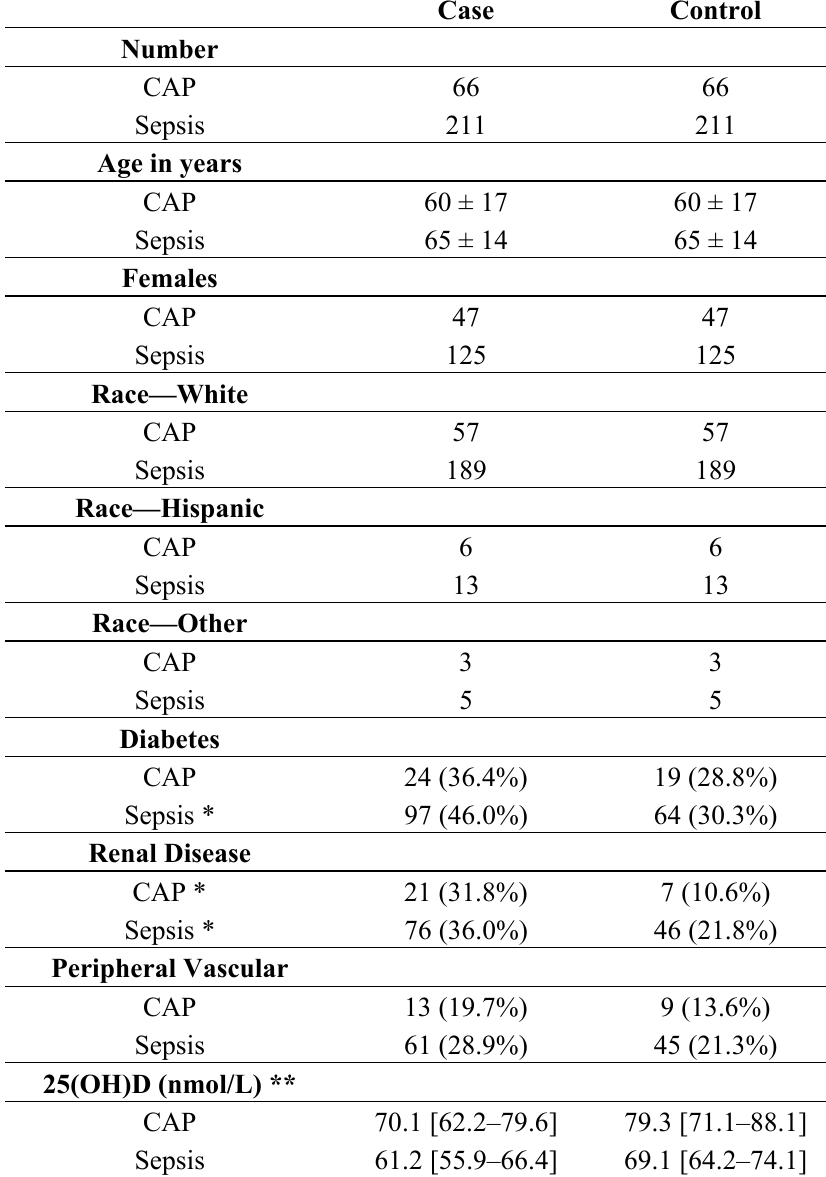
Table 1. Baseline characteristics for community-acquired pneumonia and sepsis cases and matched